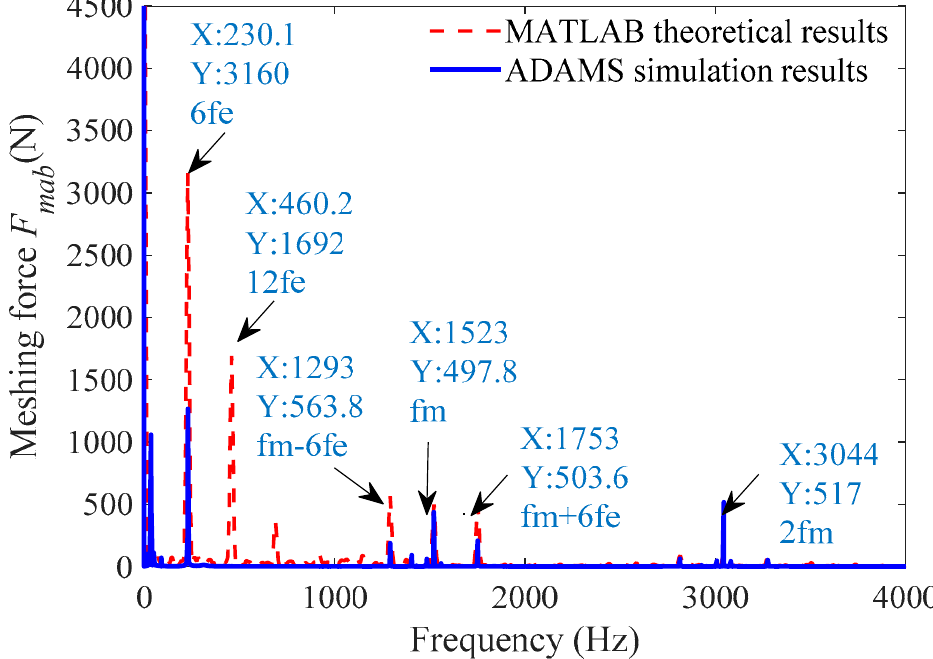
Figure 21. Frequency spectrum and time–frequency spectrum of meshing force F mab .